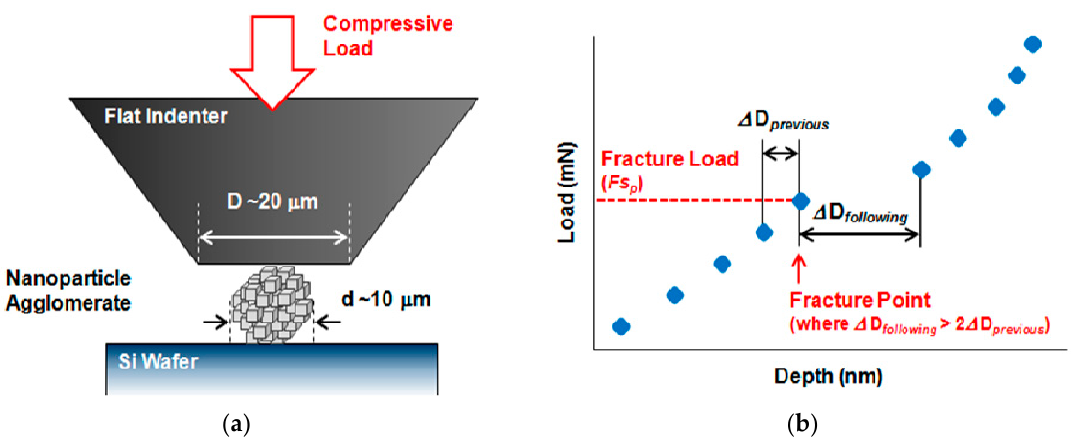
Figure 1. ( a ) Schematic illustration of fracture strength test of nanoparticle agglomerates by nano-indentation with a flat indenter tip; ( b ) Schematic load-depth diagram for the nano-indentation test.